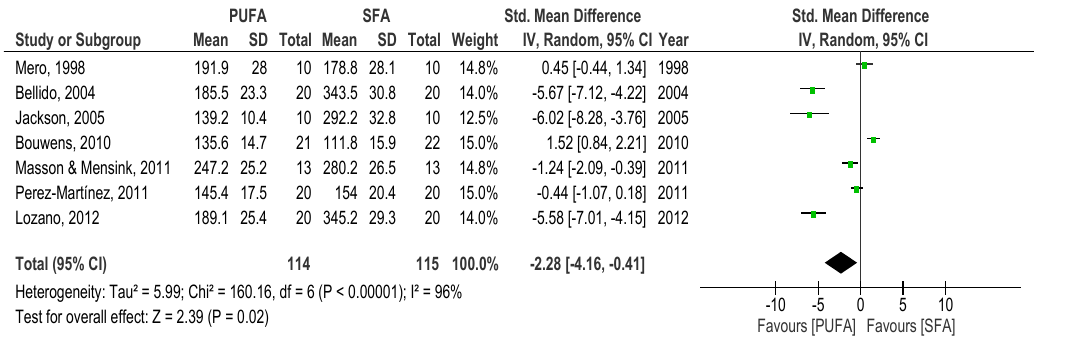
Figure 2. Forest plot of postprandial triglycerides of saturated fatty acids compared to polyunsaturated fatty acids over 8 hours.